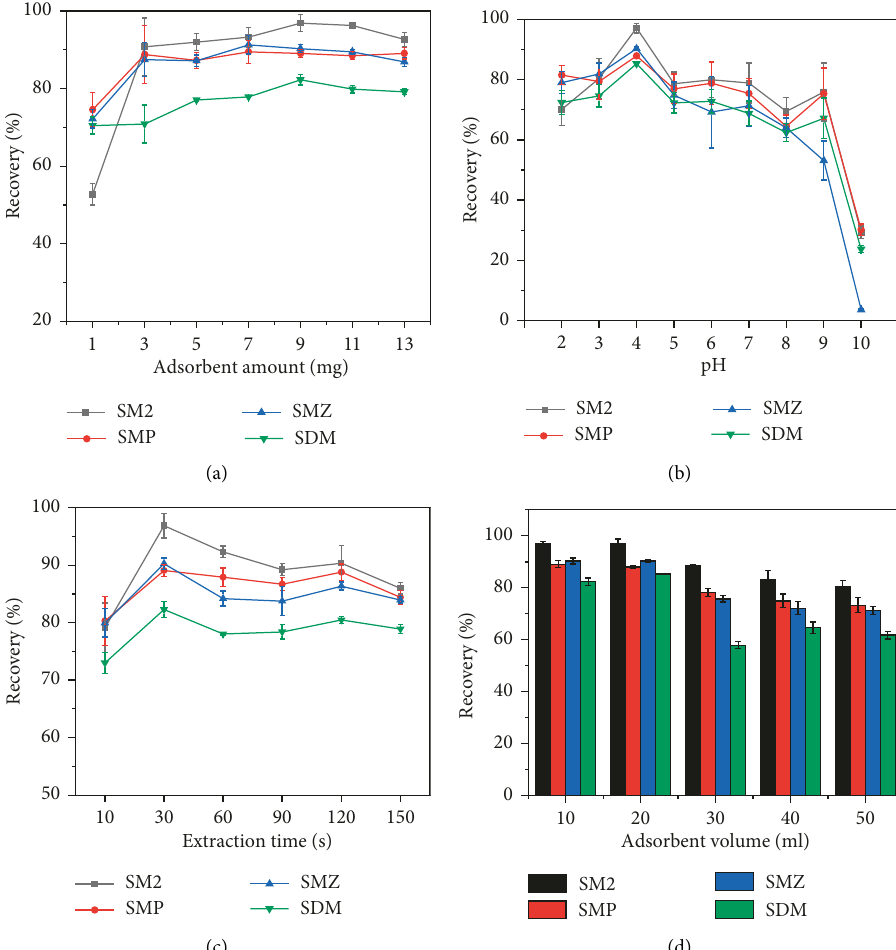
Figure 6: Recovery influence by the amount of Fe 3 O 4 @SiO 2 -NH 2 -COP (a), by pH (b), by extraction time (c), and by extraction volume (d). The concentrations of the analytes were 5.0 μ g · L − 1